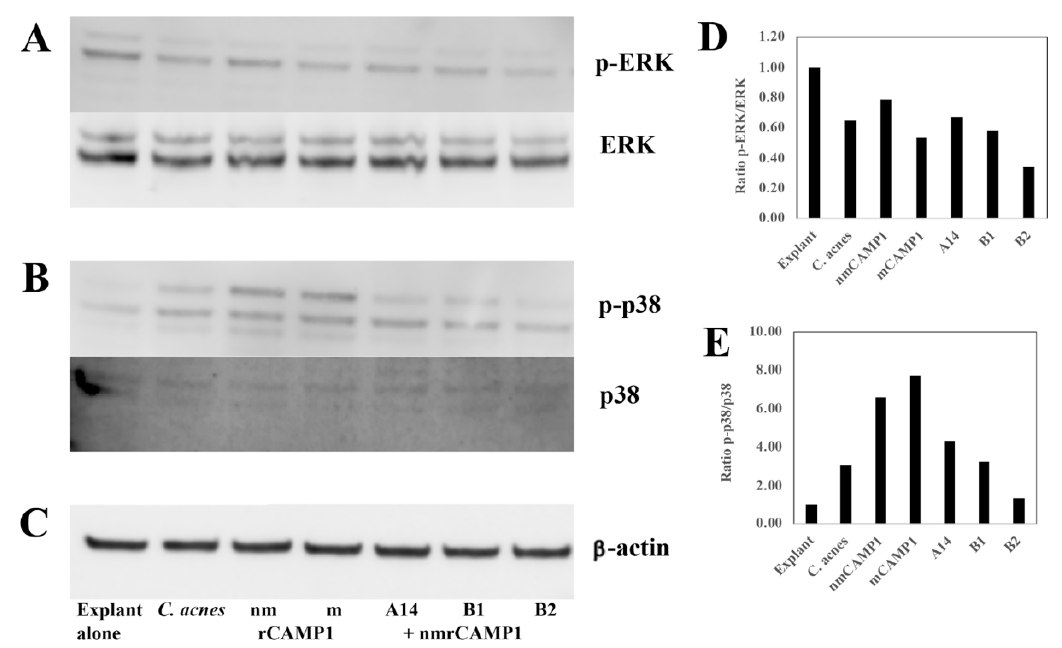
Figure 8. CAMP1-derived peptides inhibit the MAPK pathway. Human skin explants were treated for 24 h with A14, B1 or B2 peptide (62.5 μM) and were then stimulated with C. acnes (OD 620 nm = 1.0) for 18 h or with nmrCAMP1 or mrCAMP1 (10 μg/mL). Human skin explant lysates were analyzed by Western blotting with specific antibodies against ( A ) p-ERK, ERK, ( B ) p-p38, p38 and ( C ) β -actin. Blots loaded with the same protein samples were run at the same time. Densitometry analysis of the ratio of expression levels for ( D ) p-ERK/ERK, ( E ) p-p38/p38.